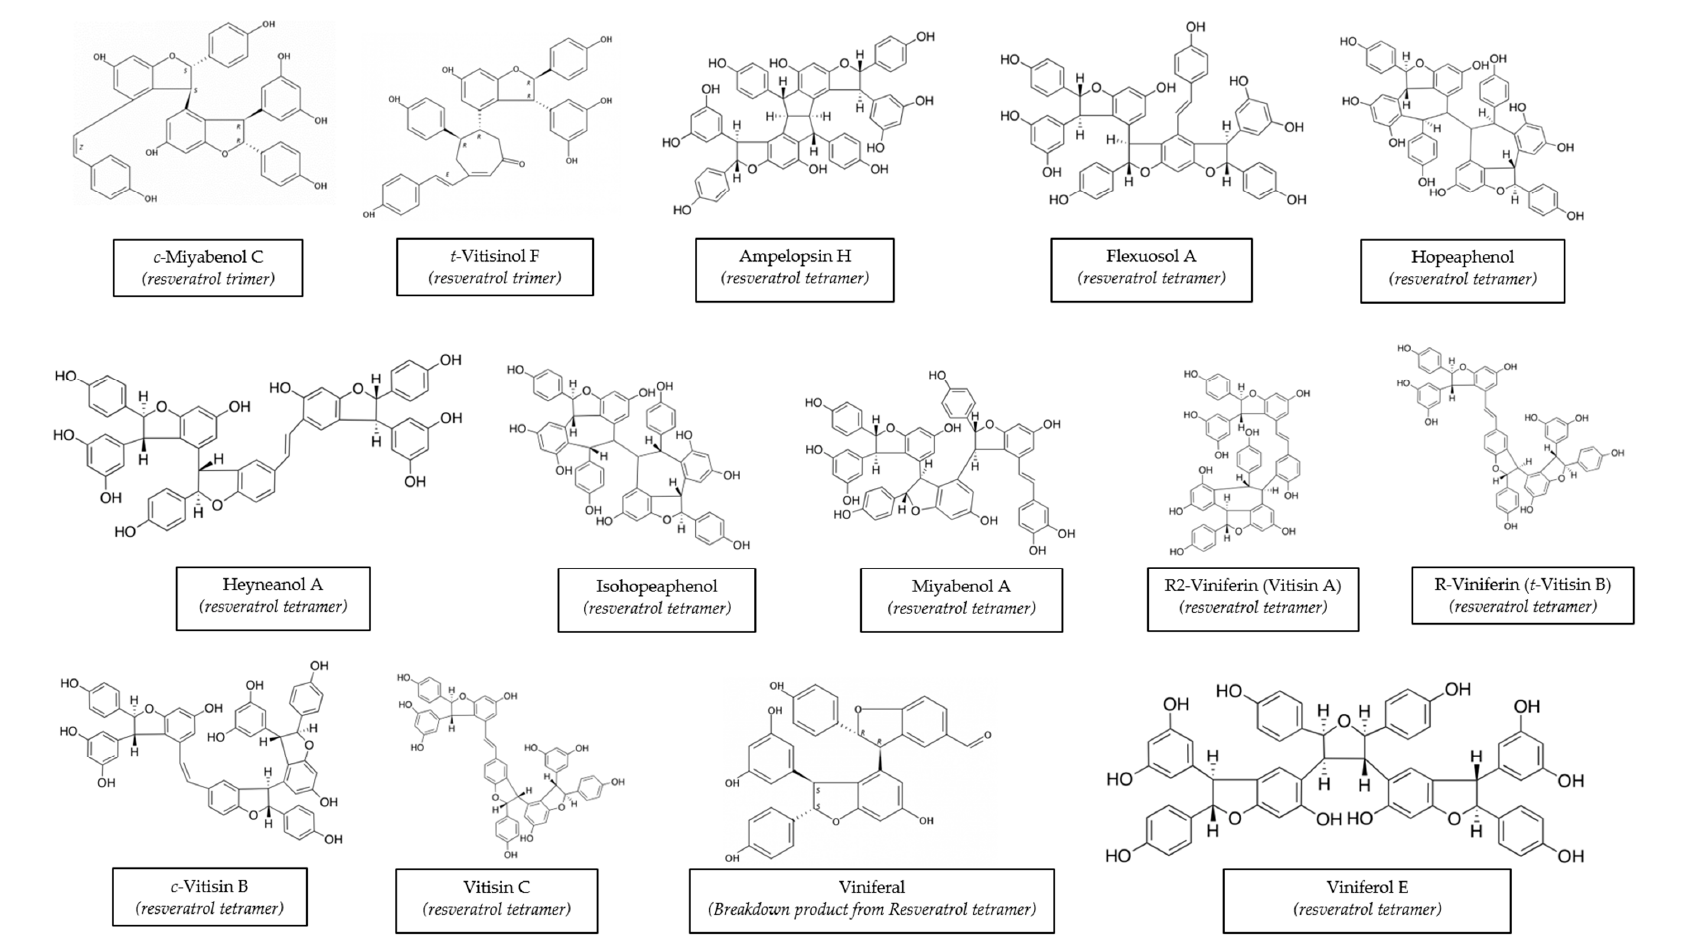
Figure 1. Structures of main stilbenes from grapevine canes. Structures obtained from the ISVV-Polyphenols reference database [49].